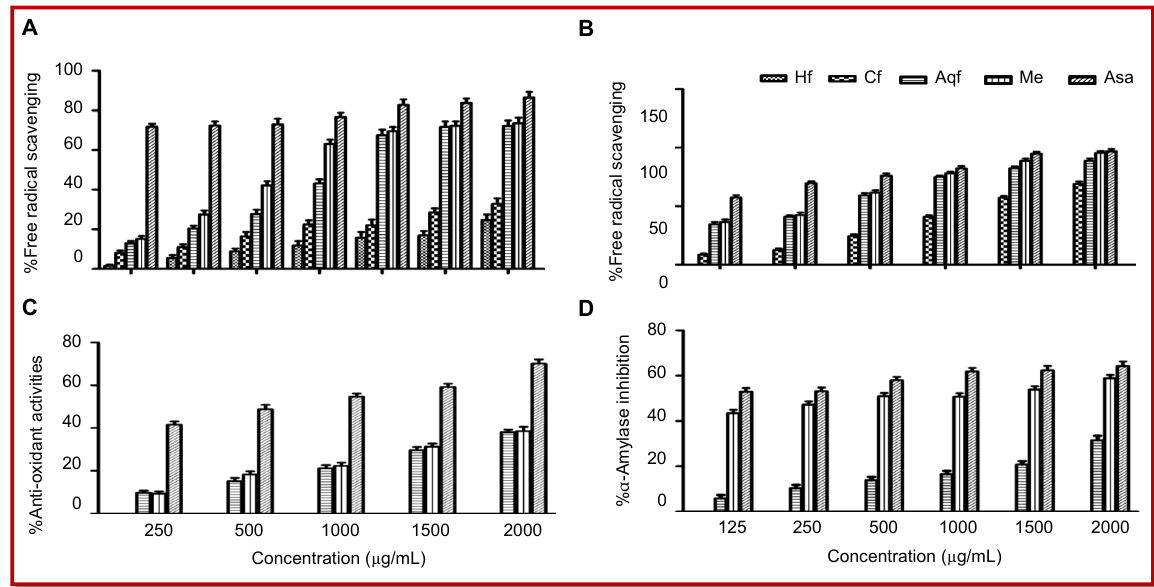
Figure 1: DPPH free radical scavenging capability (A), ABTS free radical scavenging capability (B), H 2 O 2 free radical scavenging capability (C) and anti-diabetic activity (D) of the S. halepense methanolic extract and its fractions; Hf: n-Hexane fraction, Cf: chloroform fraction, Me: methanolic extract, Aqf: aqueous fraction and Asa: ascorbic acid; n-hexane fraction did not show anti-oxidant activity in B; hexane fraction and Cf: chloroform fraction did not show anti-oxidant activities in C; hexane fraction and Aqf: